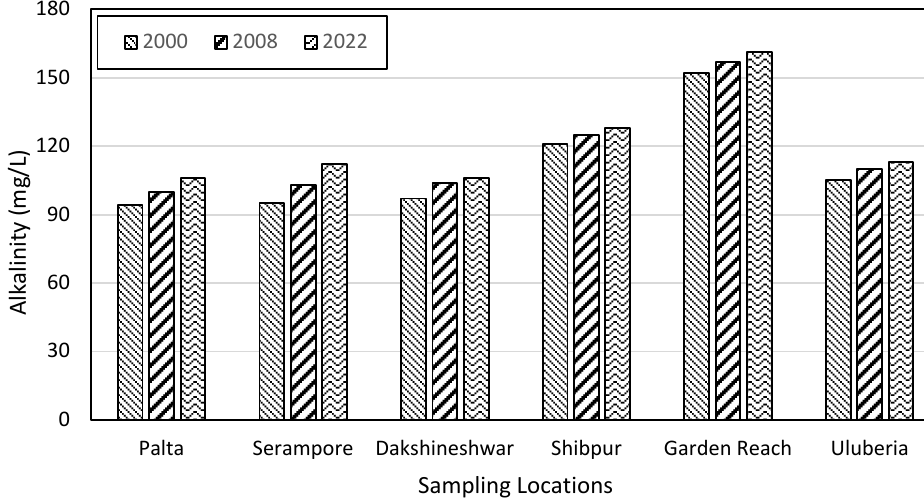
Figure 7. Variation of pH in different locations.